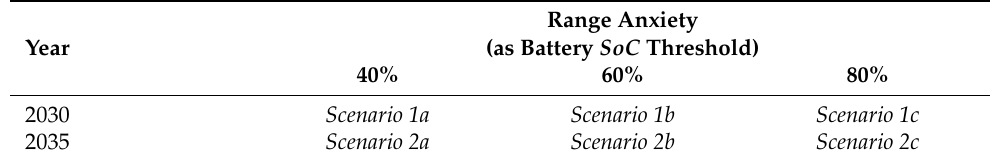
Table 6. Simulated scenarios for the city of Turin.